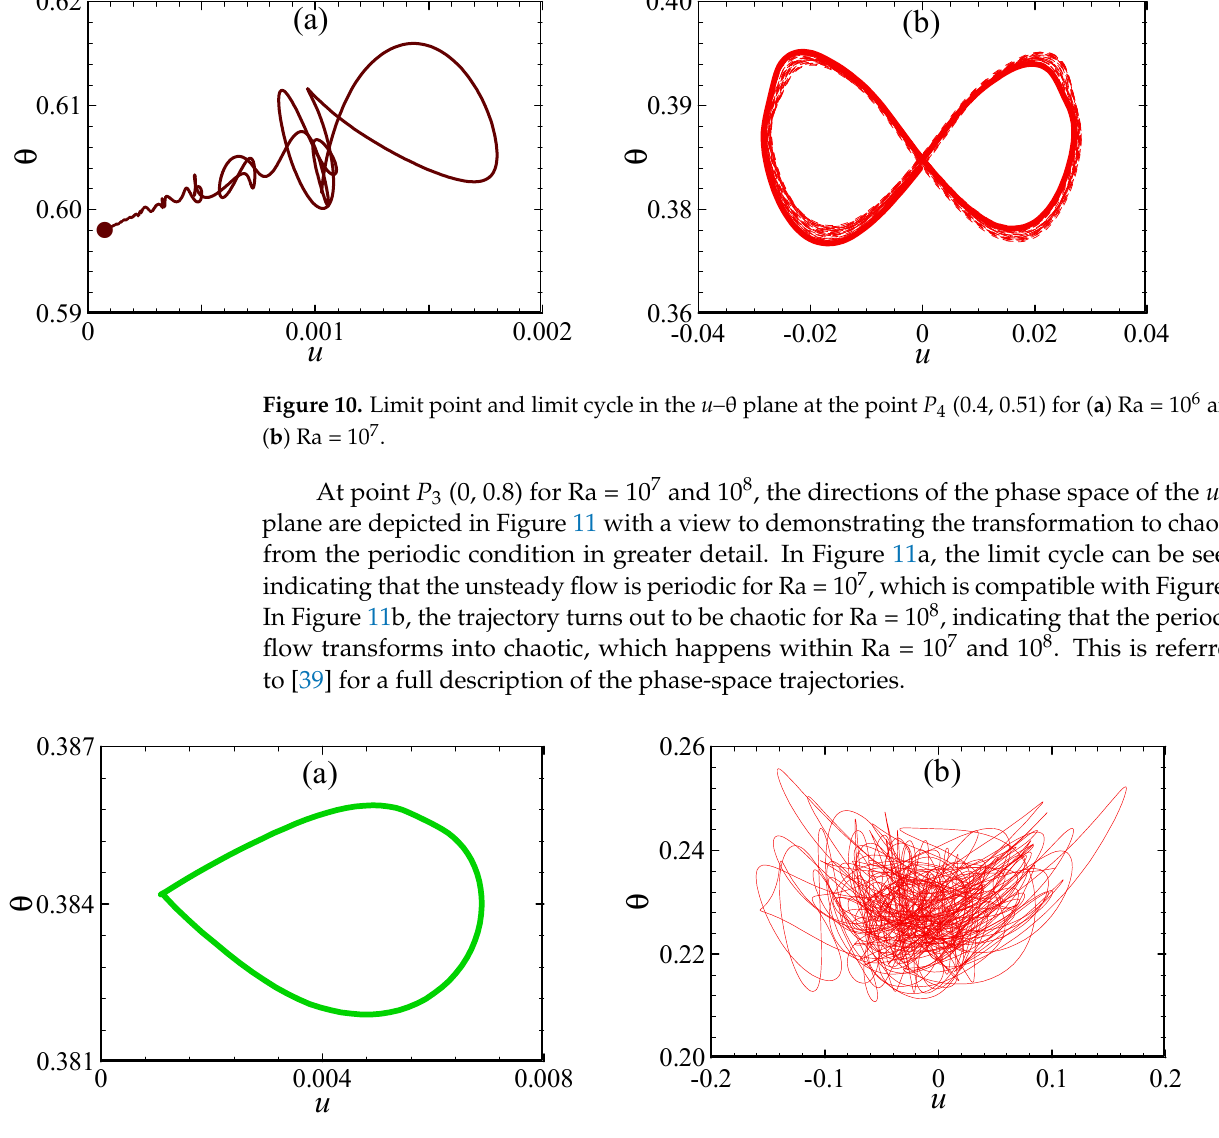
Figure 9. At the fully developed stage, temperature timeseries at point P 3 (0, 0.8) for ( a ) Ra = 10 6 , ( b ) Ra = 10 7 , and ( c ) Ra = 10 8 .